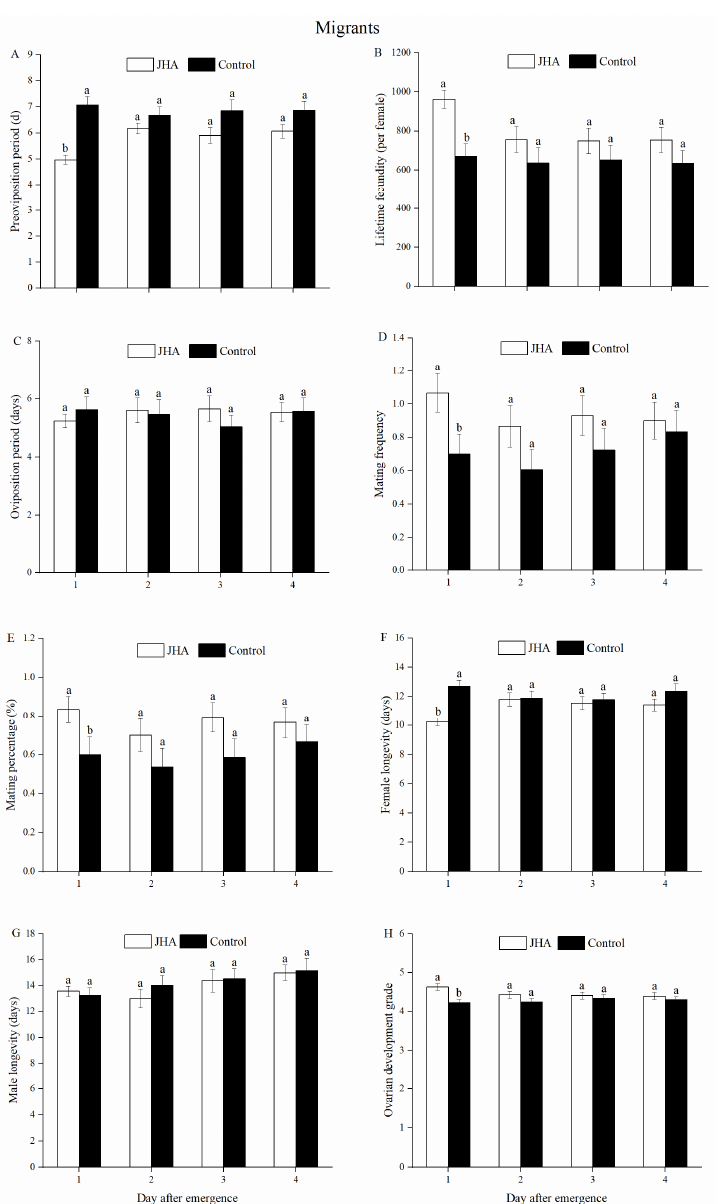
Figure 4. Reproductive performances of M. separata migrants between the JHA and control groups at various ages. ( A ) Pre-oviposition period. ( B ) Lifetime fecundity. ( C ) Oviposition period. ( D ) Mating frequency. ( E ) Mating percentage. ( F ) Female longevity. ( G ) Male longevity. ( H ) Ovarian development grade. Different lowercase letters indicate significant differences between the JHA and control treatments in the same bars at the 5% level by Tukey’s HSD test. Sample sizes (left to right) of JHA groups are 30, 30, 29 and 30 pairs, and of control groups are 30, 28, 29, and 30 pairs,